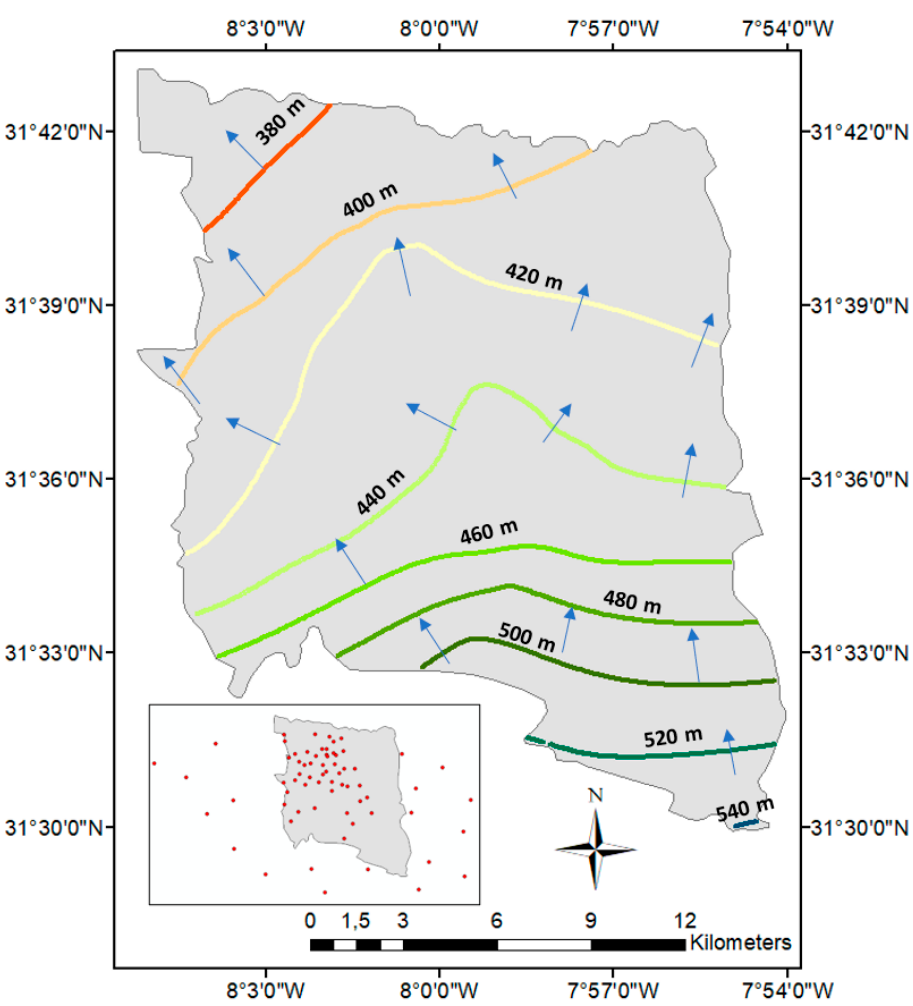
Figure 7. Trend of the water table in 2019. Points indicate sampling wells (box at the lower left); arrows indicate flow direction.